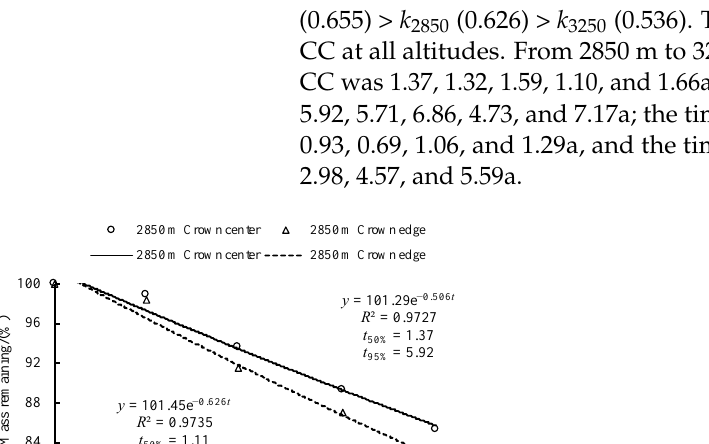
Figure 7. Initial decomposition rate (g·day − 1 ) of Qinghai spruce leaf litter from CC and CE at differ- ent altitudes in the growing season. ( a ) Represents the initial decomposition rate of Qinghai spruce leaf litter in 2850m CC and CE plots. ( b ) Represents the initial decomposition rate of Qinghai spruce leaf litter in 2950m CC and CE plots. ( c ) Represents the initial decomposition rate of Qinghai spruce leaf litter in 3050m CC and CE plots. ( d ) Represents the initial decomposition rate of Qinghai spruce leaf litter in 3150m CC and CE plots. ( e ) Represents the initial decomposition rate of Qinghai spruce leaf litter in 3250m CC and CE plots. Notes: Values are from bulk litter of CC and CE sites. n = 5. NS., p > 0.05; **, p < 0.0l; ***, p < 0.001.